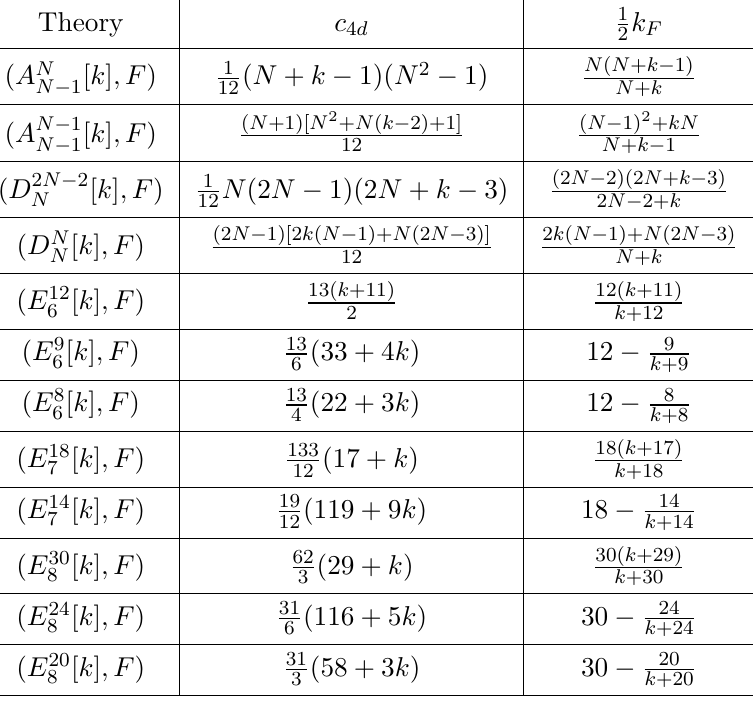
Table 5 . The central charge c 4 d and (cid:13)avor central charge k F for the Argyres-Douglas matter.